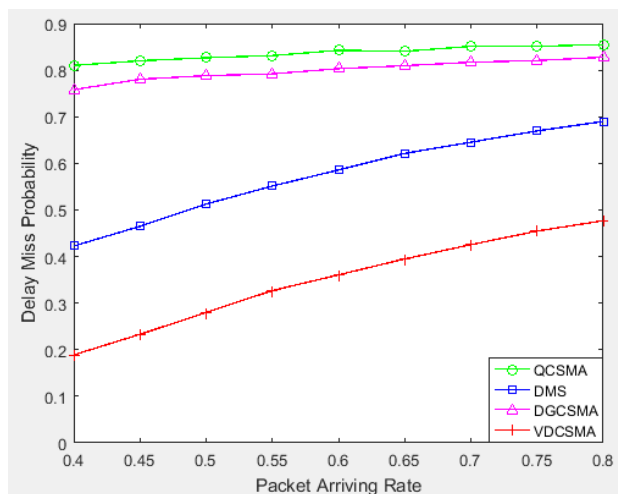
Figure 12. Delay missing probability of real-time links: λ ∈ [ 0.4,0.8 ] .